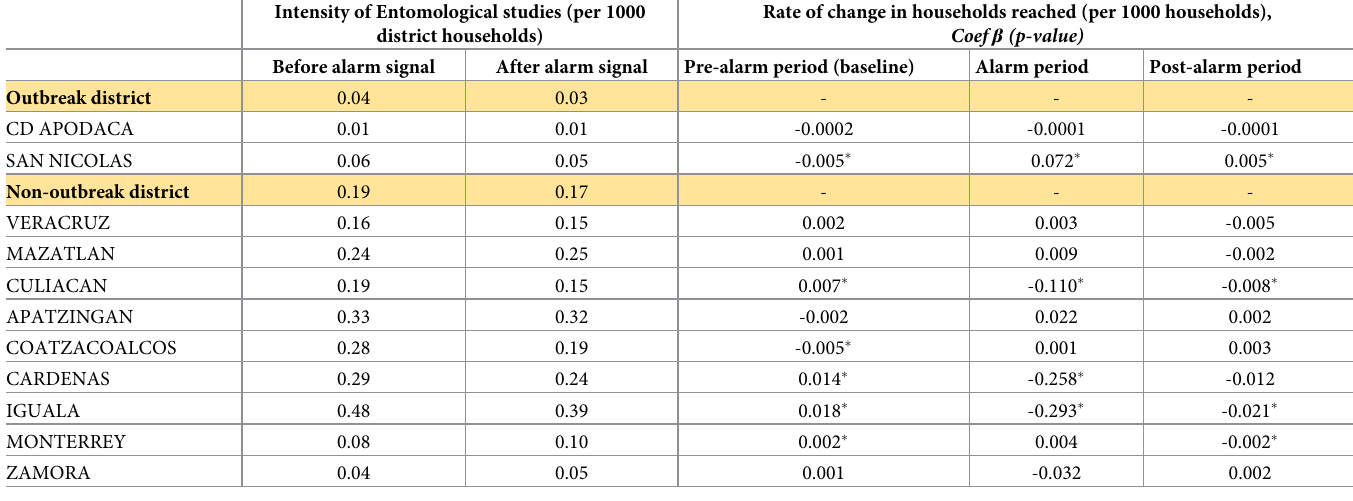
Table 4. Intensity of entomological studies. Household coverage (per 1000) before and after alarm signals and rate of change between periods in 2 outbreak and 9 non- outbreak districts with alarm signals. Intensity of Entomological studies (per 1000 Rate of change in households reached (per 1000 households), district households) Coef β (p-value) Before alarm signal After alarm signal Pre-alarm period